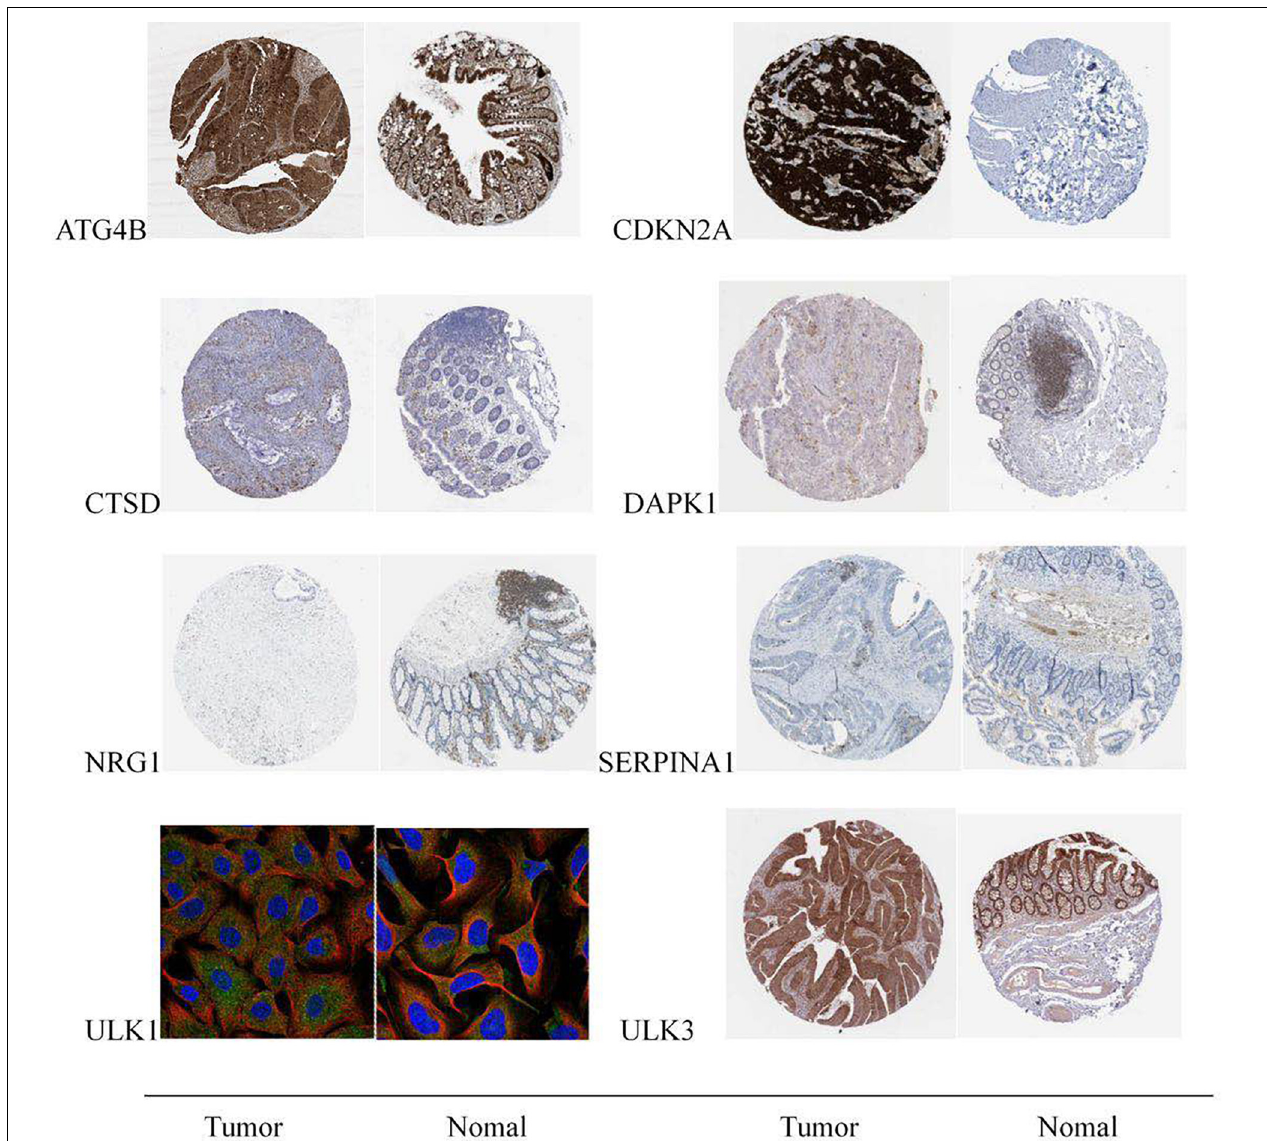
FIGURE 8 | Expression of eight prognostic-related autophagy genes in colon cancer tumor tissues and normal